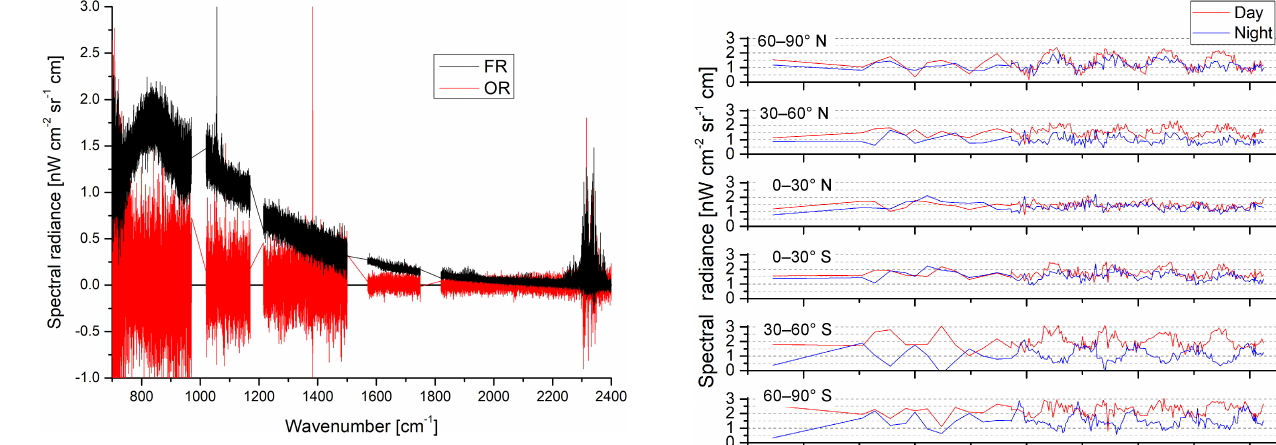
Figure 13. Difference between spectra of forward and reverse sweep direction for FR mode (black) and OR mode (red) at about 70km tangent altitude. 35000 and 3800 spectra have been co-added per sweep direction for FR and OR mode, respectively.